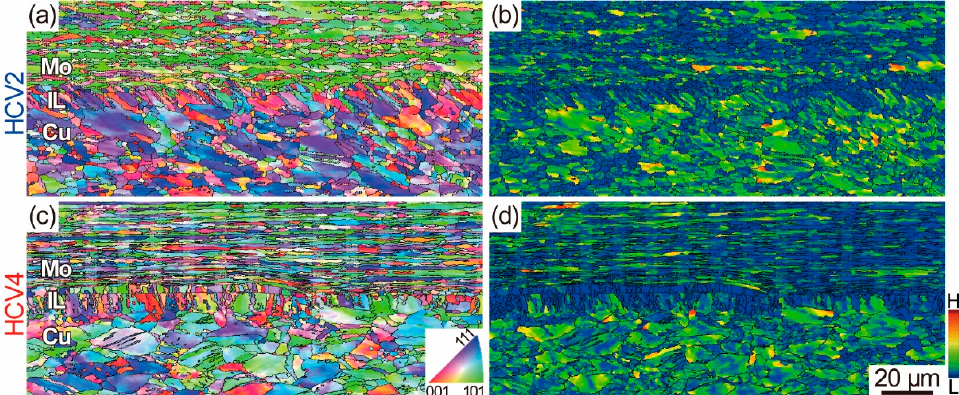
Figure 5. Cross-sectional ( a , c ) electron-back-scattered-diffraction (EBSD) - inverse-pole-figure (IPF) and ( b , d ) EBSD - grain-reference-orientation-deviation (GROD) maps of as-explosive-welded ( a , b ) HCV2 and ( c , d ) HCV4 clads. The intermediate layers (ILs) produced at the Mo/Cu interfaces.